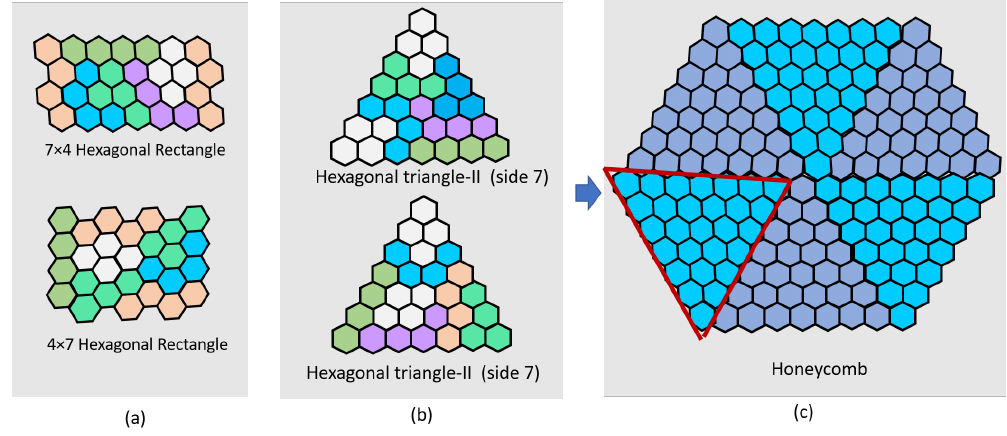
Figure 11. Planar tetrahex patterns in different tiling sets including ( a ) 7 × 4 and 4 × 7 hexagonal rectangle, ( b ) hexagonal triangle-I, and hexagonal triangle-II, and ( c )